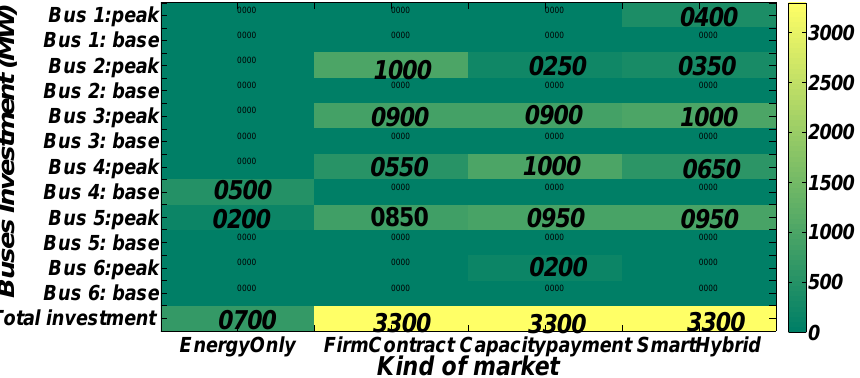
Figure 6. Strategic producer investments’ comparisons in each localized test voltage/power bus.